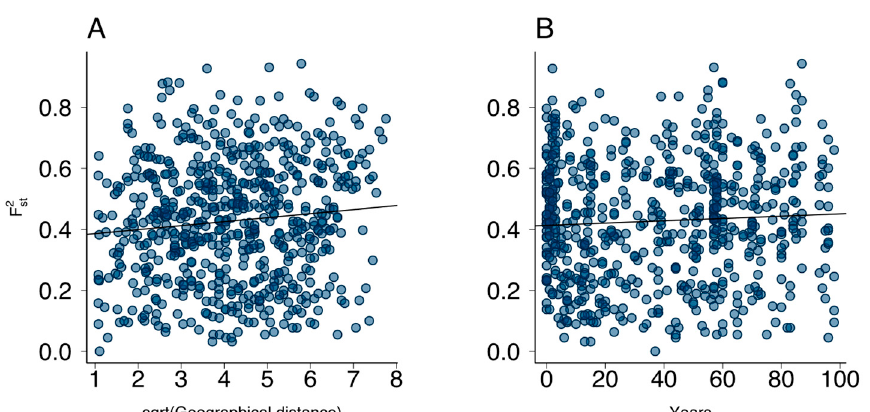
Figure 10. Plots showing isolation by distance ( A ) and year ( B ) for the contemporary dataset.